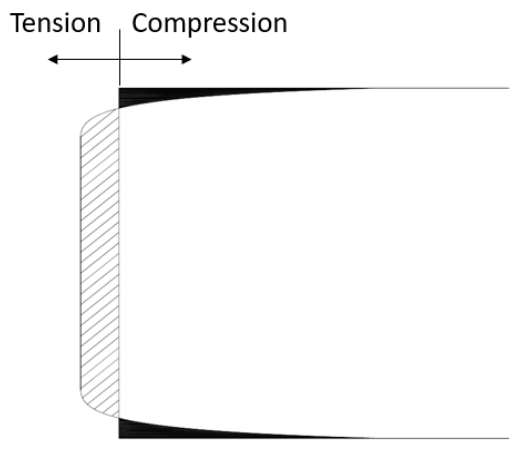
Figure 2. Stress distribution on vertical specimen diameter in splitting test [24].